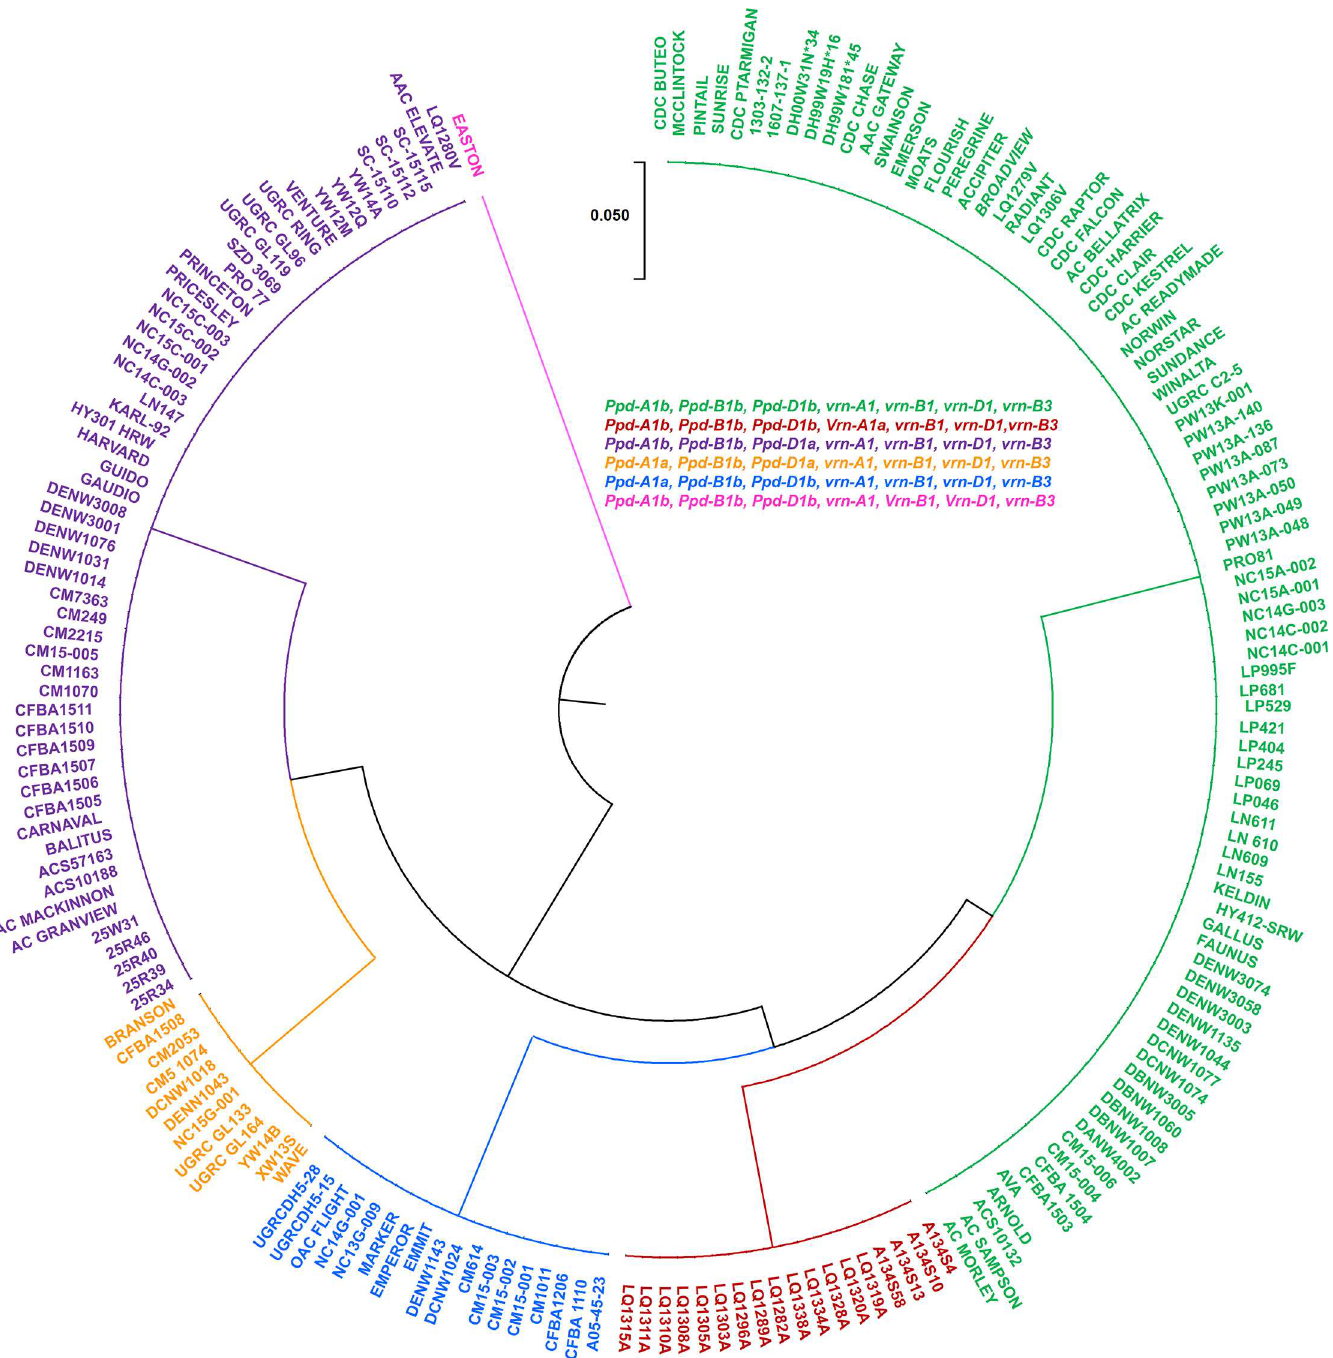
Fig 1. Dendrogram of genotype loci combinations. In clock wise order ; Ppd-A1b/Ppd-B1b/Ppd-D1b/vrn-A1/vrn-B1/vrn-D1/vrn-B3 (green), Ppd-A1b/Ppd-B1b/Ppd- D1b/Vrn-A1a/vrn-B1/vrn-D1/vrn-B3 (red), Ppd-A1a/Ppd-B1b/Ppd-D1b/vrn-A1/vrn-B1/vrn-D1/vrn-B3(blue) , Ppd-A1a/Ppd-B1b/Ppd-D1a/vrn-A1/vrn-B1/vrn-D1/vrn-B3 (yellow), Ppd-A1b/Ppd-B1b/Ppd-D1a/vrn-A1/vrn-B1/vrn-D1/vrn-B3 (Purple), Ppd-A1b/Ppd-B1b/Ppd-D1b/vrn-A1/Vrn-B1/Vrn-D1/ vrn-B3 (Pink).